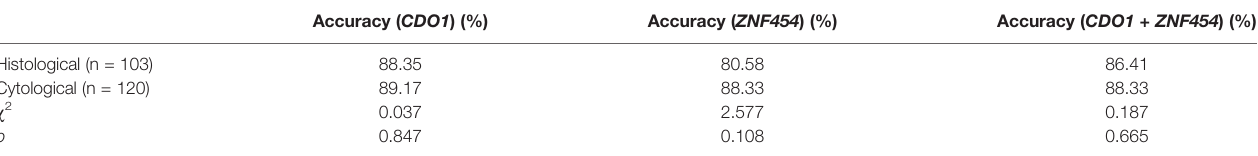
TABLE 2 | Comparison of gene methylation level on diagnostic